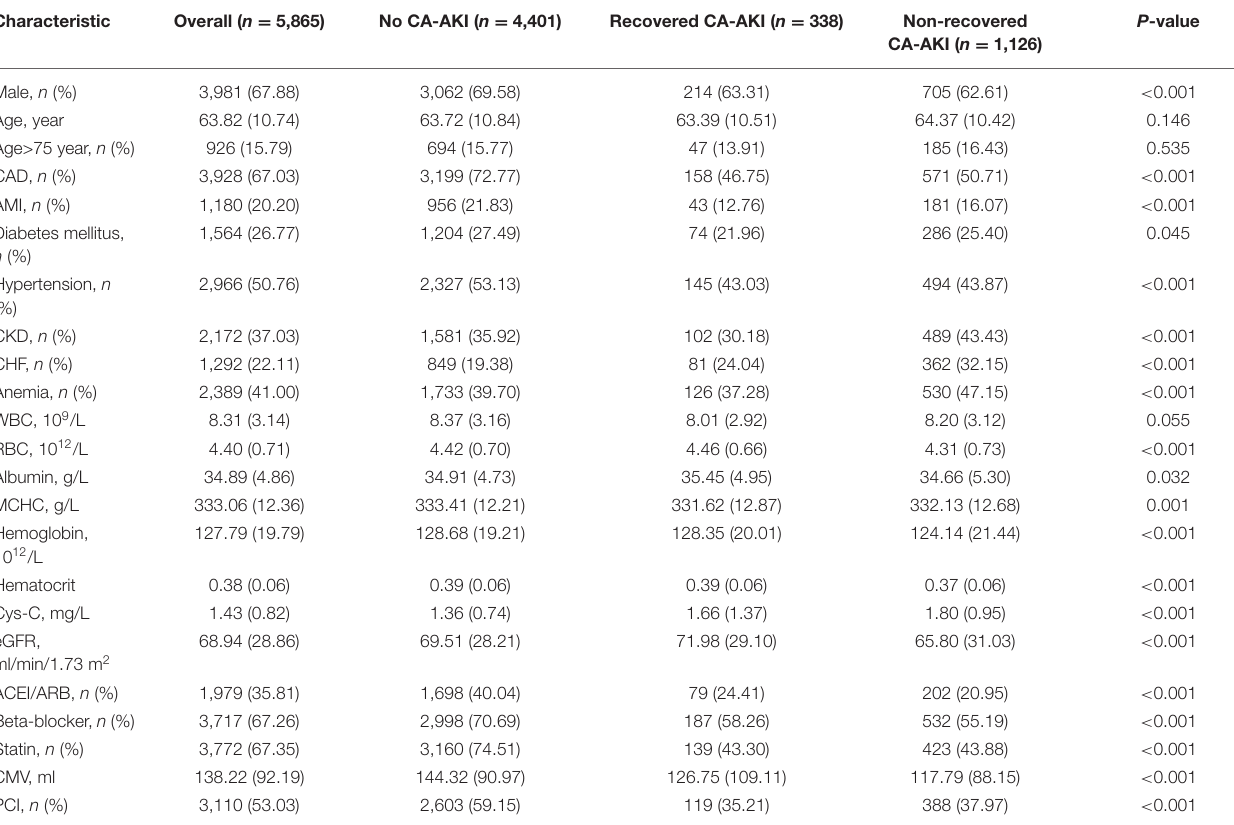
TABLE 1 | Baseline